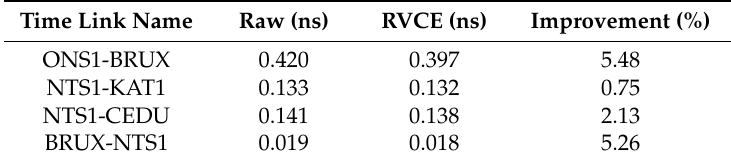
Figure 5. Smoothing residuals of the results with and without the RVCE approach for the four time links. ( a ) is for ONS1-BRUX, ( b ) is for NTS1-KAT1, ( c ) is for NTS1-CEDU and ( d ) is for BRUX-NTS1. Table 4. Improvement (%) in RMS of the result smoothing in two scenarios for the time links.